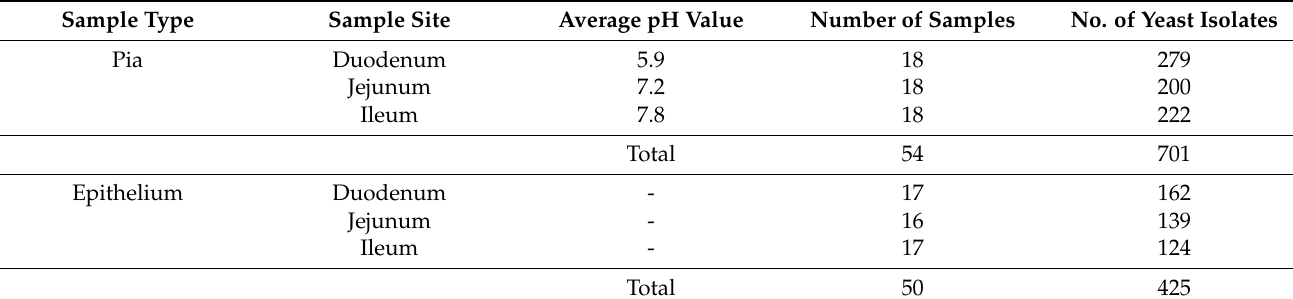
Table 1. Number of yeast isolates isolated from pia and small-intestinal epithelium samples collected from the slaughter- house of Pon Yang Kham Livestock Breeding Cooperative N.S.C., Ltd., in Sakon Nakhon Province,